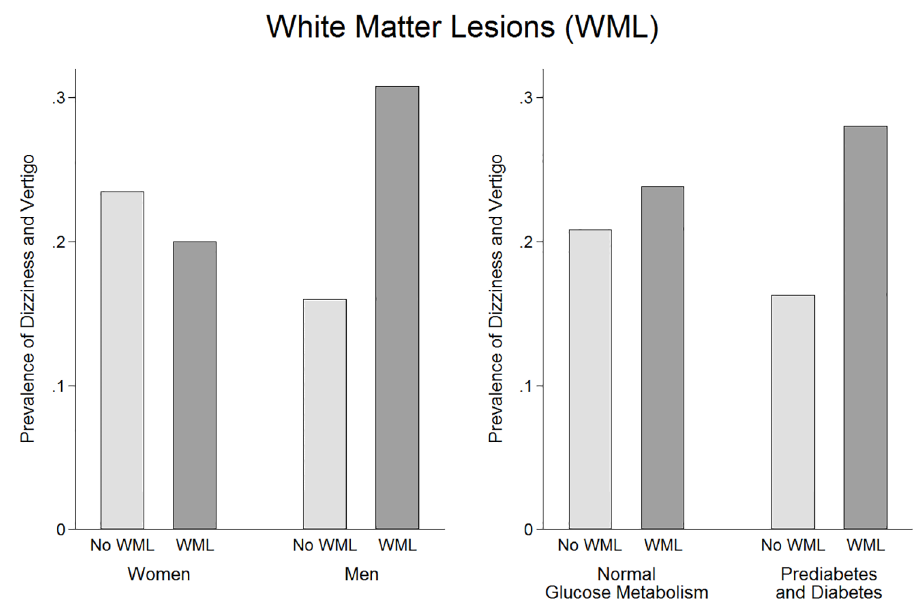
Fig 1. Prevalence of 12-month dizziness and vertigo according to groups with and without white matterlesions. In women and men (Panel A) and in personswith normalglucosemetabolismand in prediabeticor diabetic persons(Panel B).